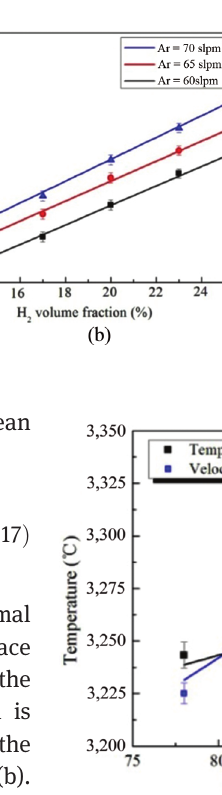
Figure 12: Effect of total Ar þ H 2 gas flow rate on particles surface temperature and flight velocity at the spraying distance of 100 mm with a constant H 2 volume fraction of 23%, current of 420 A and power of 65